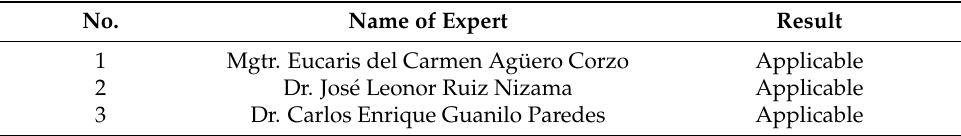
Table 1. Expert reviewers of the questionnaire.